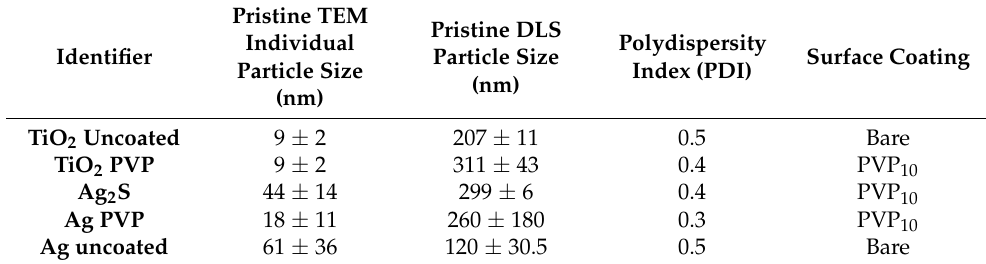
Table 1. Summary characterization data for TiO 2 and Ag NMs. From Ellis et al., 2020